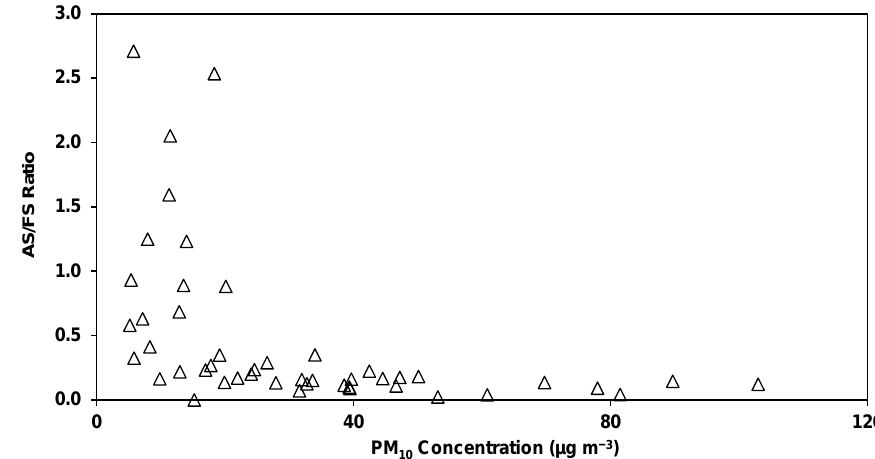
Figure 8. Ratio of aged over fresh sea salt (AS/FS) as a function of PM 10 concentration.